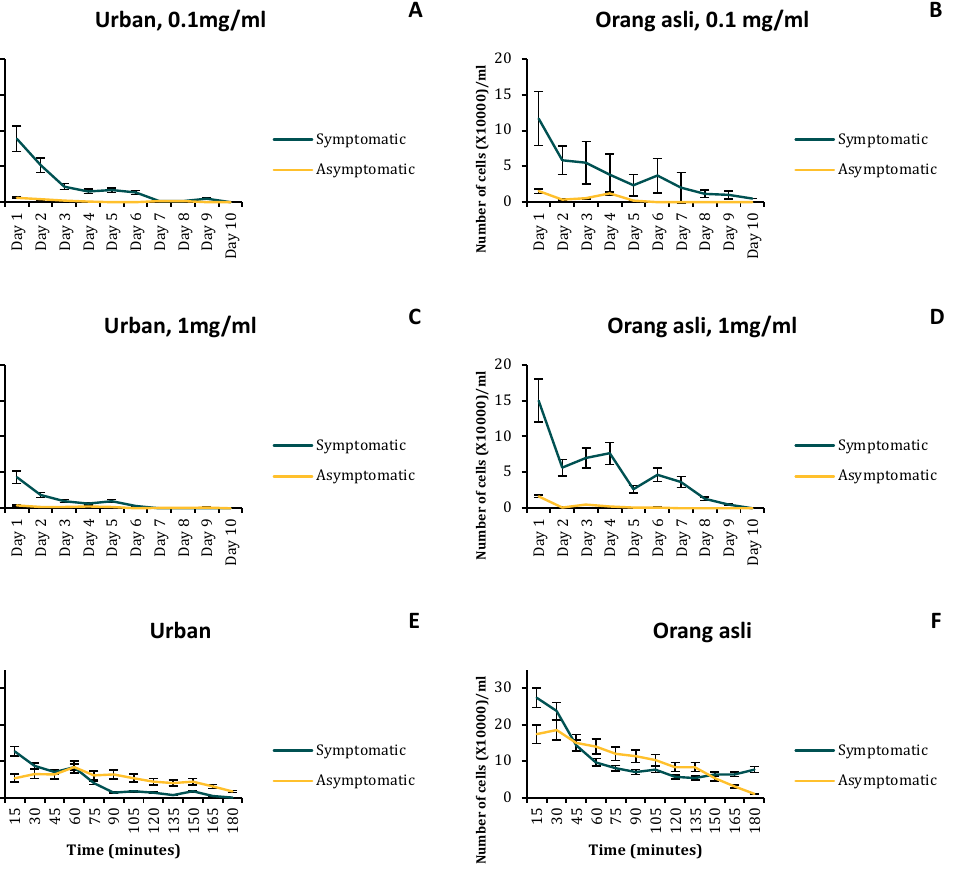
Figure 5. Resistance towards metronidazole (MTZ) and distilled water in vitro. ( A – D ) The growth profile of Blastocystis sp. was treated with MTZ at 0.1 mg/mL and 1 mg/mL. ( E , F ) Blastocystis sp. obtained from urban and orang asli inoculated in distilled water. Blastocystis sp. isolated from orang asli individuals showed greater robustness than parasites obtained from urban individuals. Values are expressed as mean ± SD.